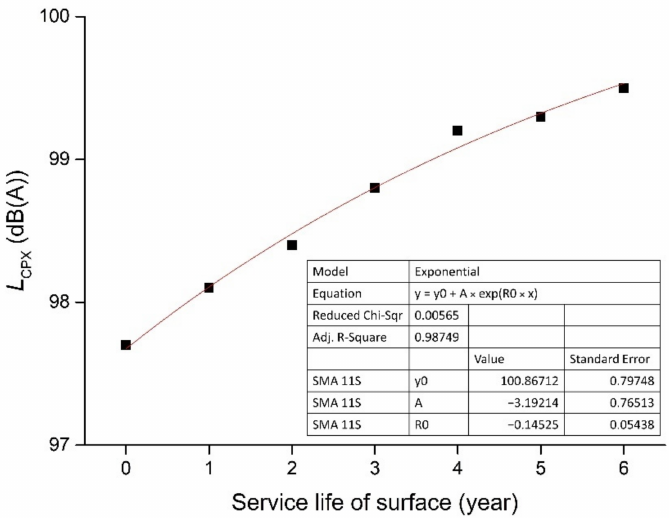
Figure 10. Median noise values for the SMA 11S surface fitted to exponential